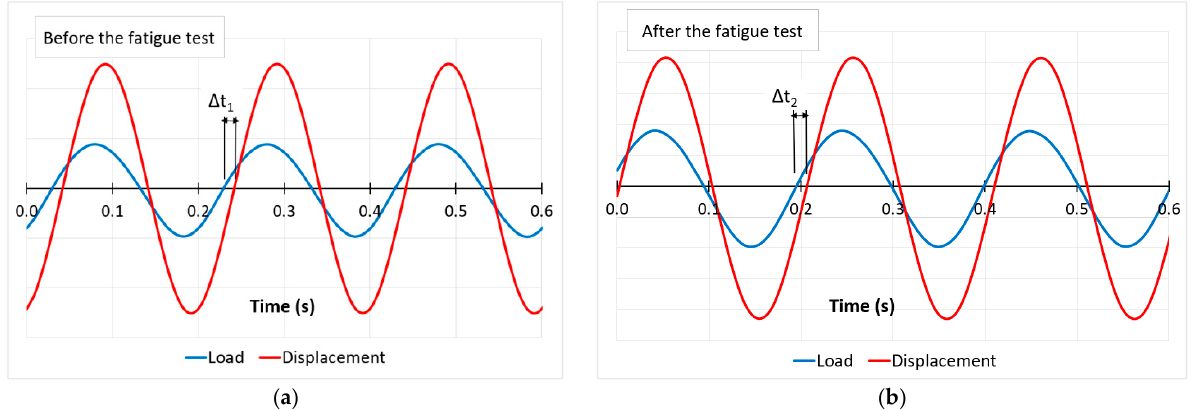
Figure 8. Example of load and displacement variability of Mat B (specimen 2) in 0.6 sec (cycles transformed to mean value = 0). The phase shift (delay) of the displacement is: ( a ) Δ t 1 = 0.01311 s (before the fatigue test) and ( b ) Δ t 2 = 0.01291 s (after the fatigue test). Table 7. Experimental results of the loss factor η for Mat A.